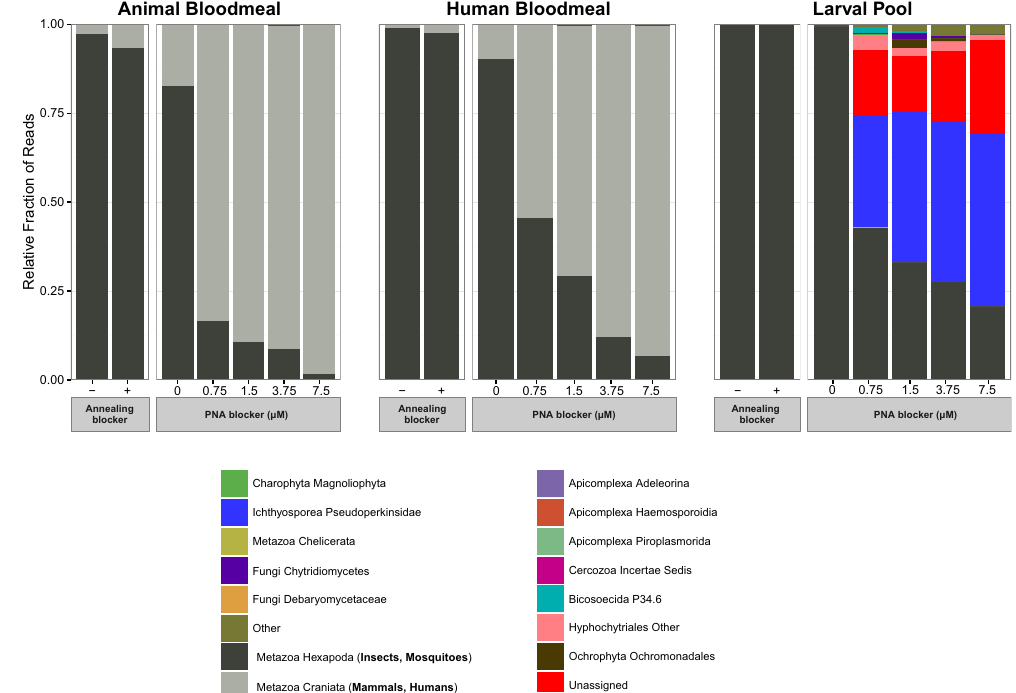
Figure 3. Taxonomic profile of 18s rRNA gene amplicons for the V4 hypervariable region generated under different blocking conditions. Mammalian and mosquito hits are shown in grey scale while those of eukaryotic microbes are shown in colour. In all three samples, use of the mosquito specific PNA blocker significantly decreased mosquito reads. In animal and human bloodmeal samples with PNA blockers, human and mammal reads were predominant, whereas in the larval pool sample, eukaryotic microbes represented the majority of sequence reads when PNA blockers were used. For simplicity, sequences were collapsed at level 6 of the Silva 119 eukaryotic taxonomy, and lineages with less than 100 total amplicons were collapsed into the Other class (12 lineages for the V4 hypervariable region; 23 lineages for the V4 hypervariable region) to facilitate legend